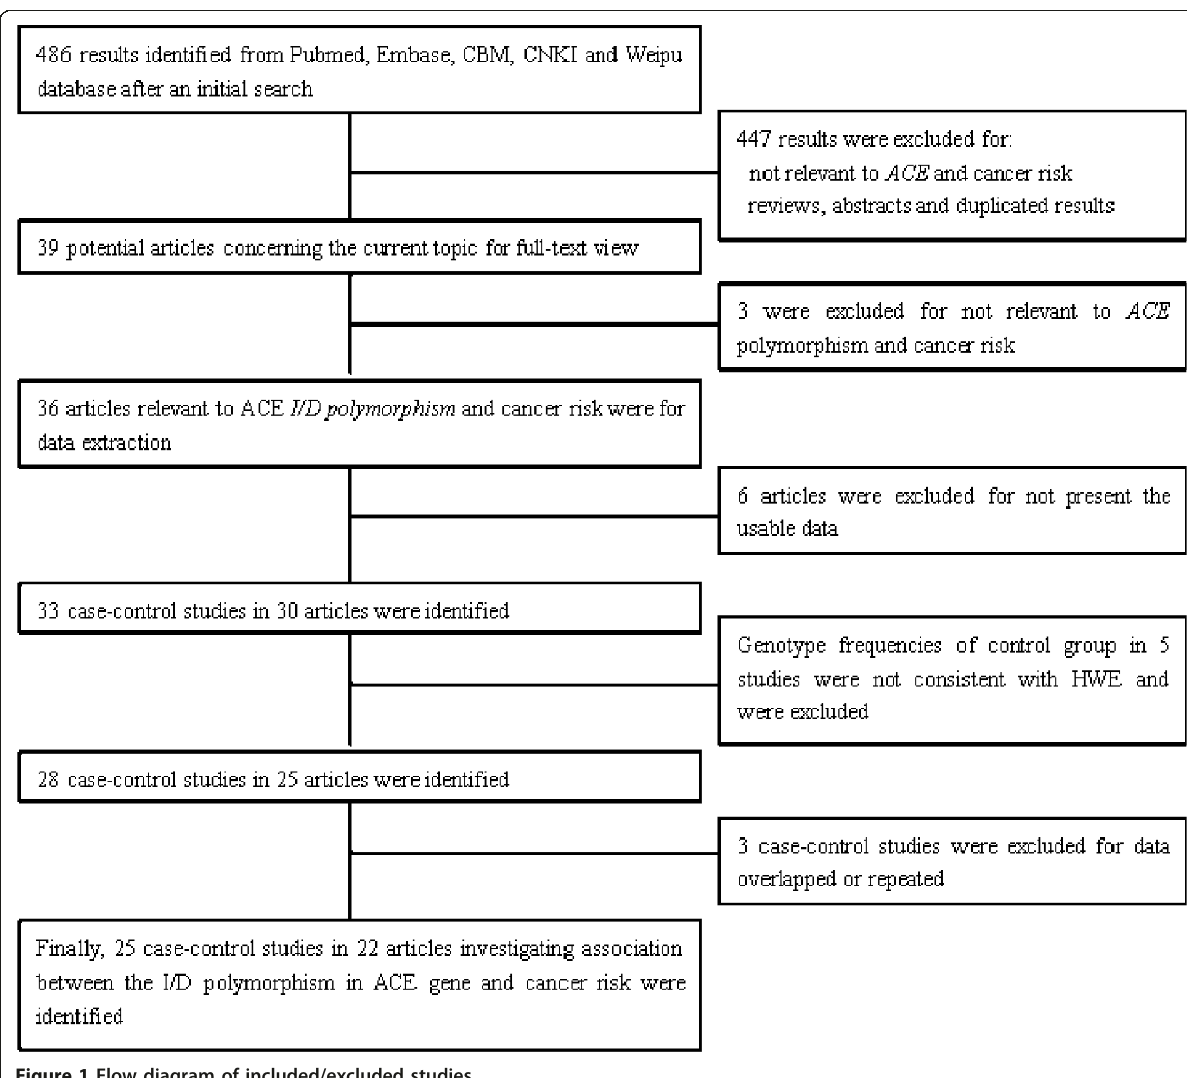
Figure 1 Flow diagram of included/excluded studies